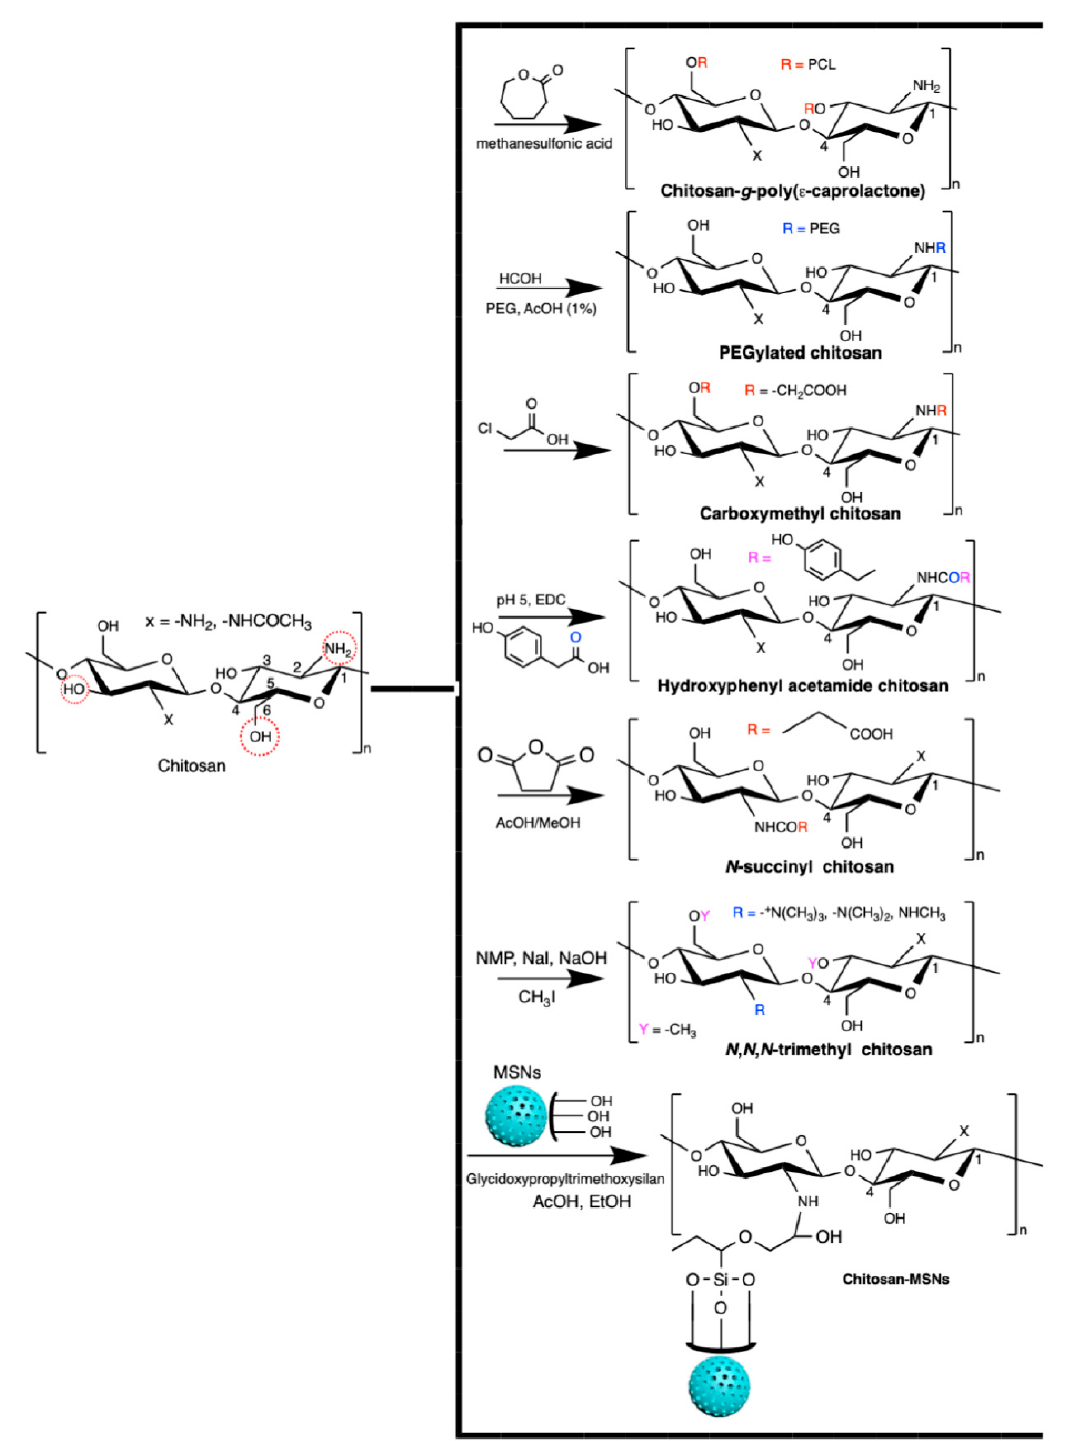
Figure 3. Chitosan-based materials used in biomedical-engineering applications.